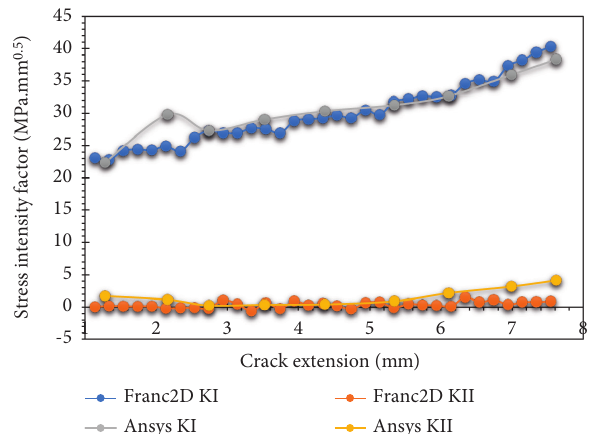
Figure 16: Stress intensity factors with corresponding crack length for CT04 specimen.